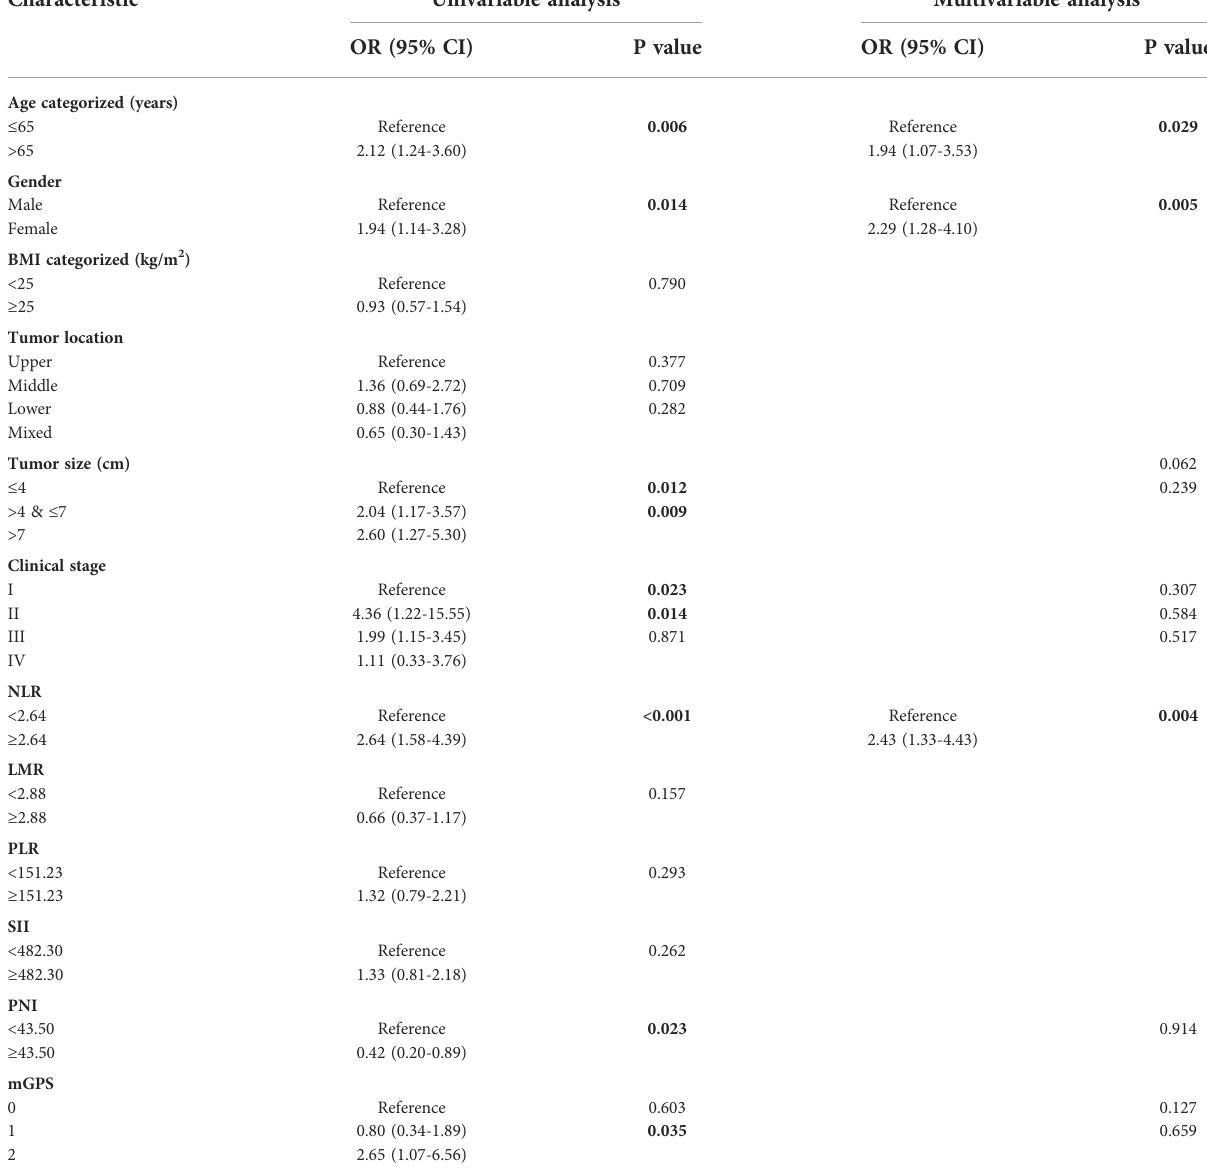
TABLE 2 Logistic regression analysis between clinicopathologic variables and